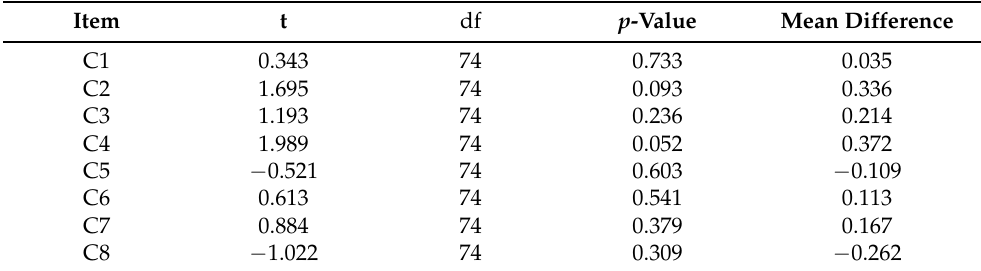
Table 6. Results of the t-test for equality of means. Questionnaire Q3 (satisfaction about the teaching method, Table 1).